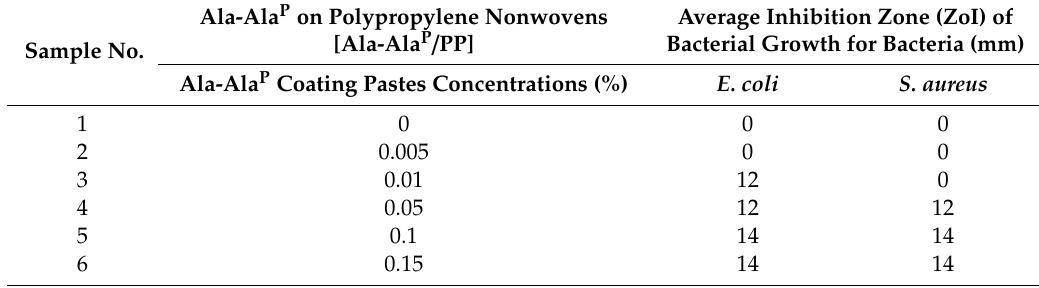
Table 8. Results of tests on the antibacterial activity of L-Ala-Ala P modified nonwovens. Average Inhibition Zone (ZoI) of Ala-Ala P on Polypropylene Nonwovens Bacterial Growth for Bacteria (mm) [Ala-Ala P / PP] Sample No. Ala-Ala P Coating Pastes Concentrations (%) E. coli S. aureus 1 0 0 0 2 0.005 0 0 3 0.01 12 0 0.05 12 0.1 0.15 14 14 Surface of applied disks with 1 cm diameter equals 0.785 cm 2 Concentration of inoculum (bacterial suspension) amount of live bacteria CFU / mL = 0.4 × 10